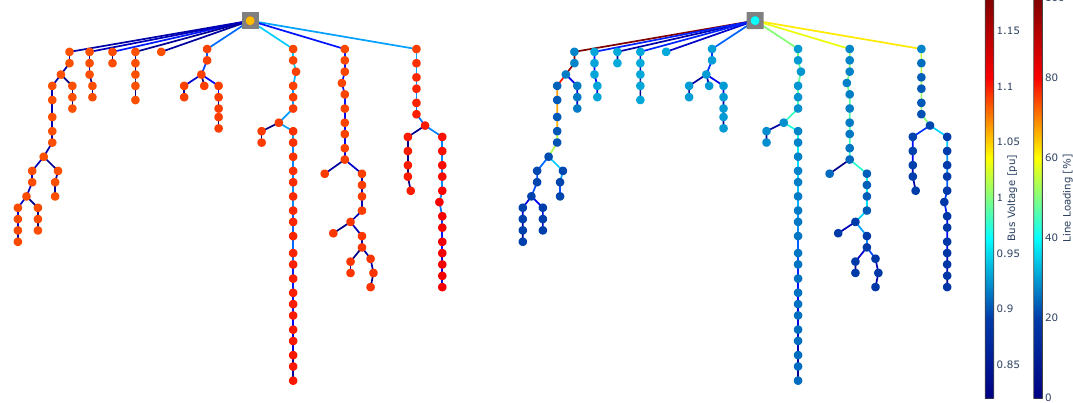
Figure 9. Heat map highlighting the line/transformer loadings and the under-/overvoltages of both future scearios of a rural LV grid: “1-LV-rural3--1-sw” in “lPV” study case ( left ) and “1-LV-rural3--2-sw” in “hL” study case ( right